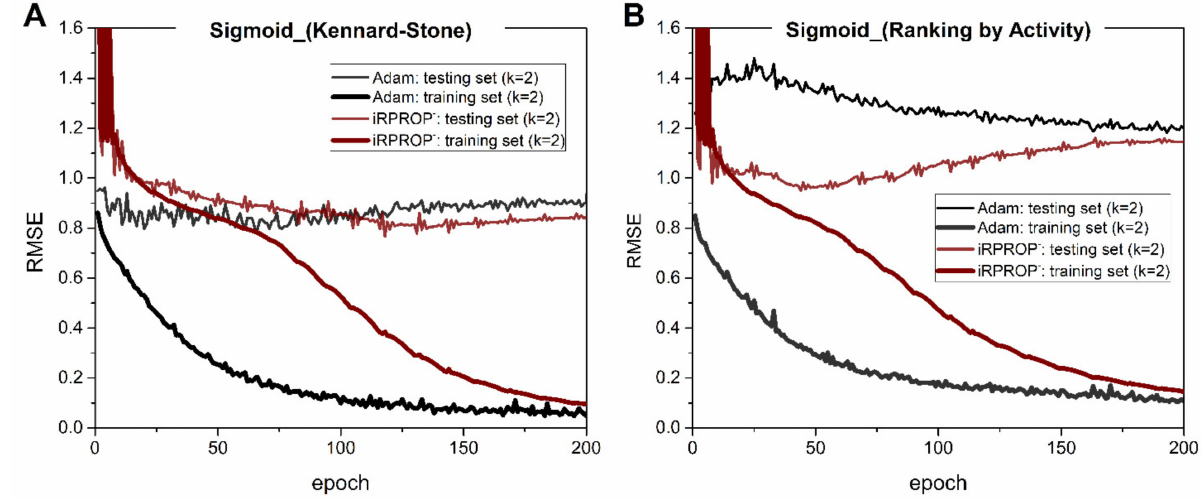
Figure 5. RMSE parameters for training and testing sets for MLPs with one hidden layer with i RPROP and Adam learning procedures and Sigmoid activation function using ( A ) Kennard–Stone and ( B ) ranking by activity-based train–test splits,